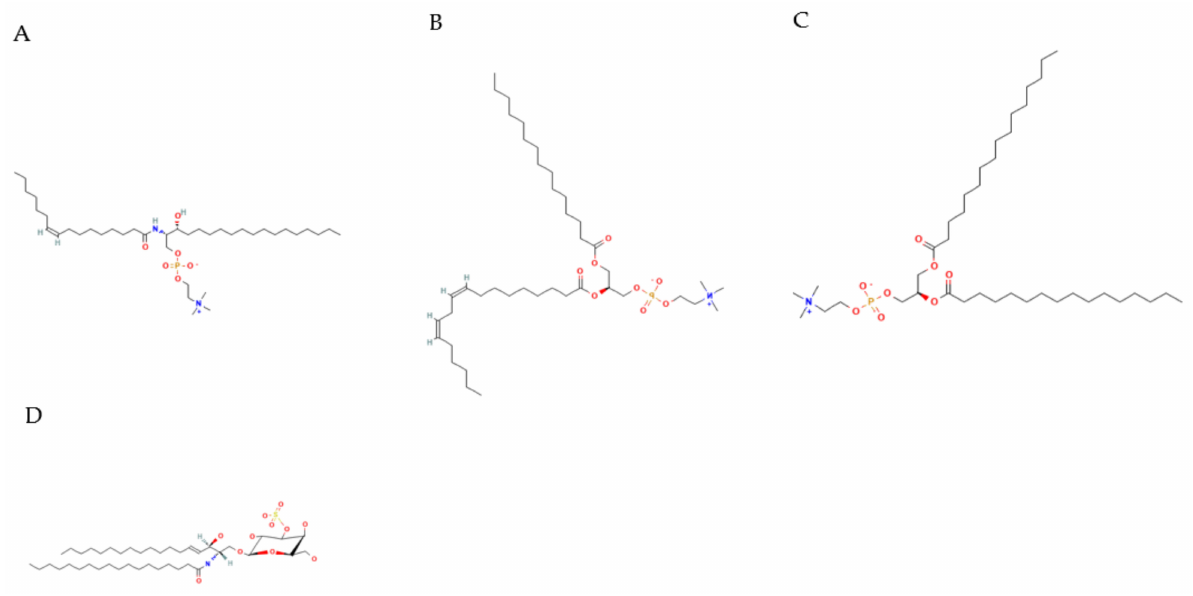
Figure 7. Molecular structure of SM(d18:0/16:1(9Z)) ( A ), PC(15:0/18:2(9Z,12Z)) ( B ), PC(16:0/16:0) ( C ), and 3-O-Sulfogalactosylceramide (d18:1/18:0) ( D